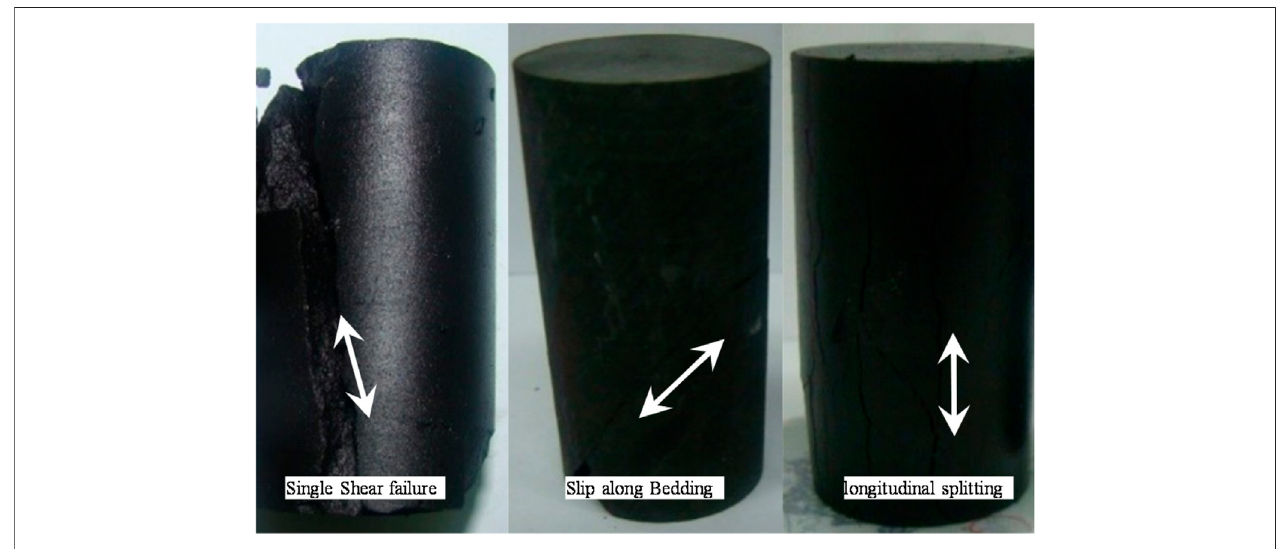
FIGURE 3 | Rock samples after failure of triaxial rock mechanics test.